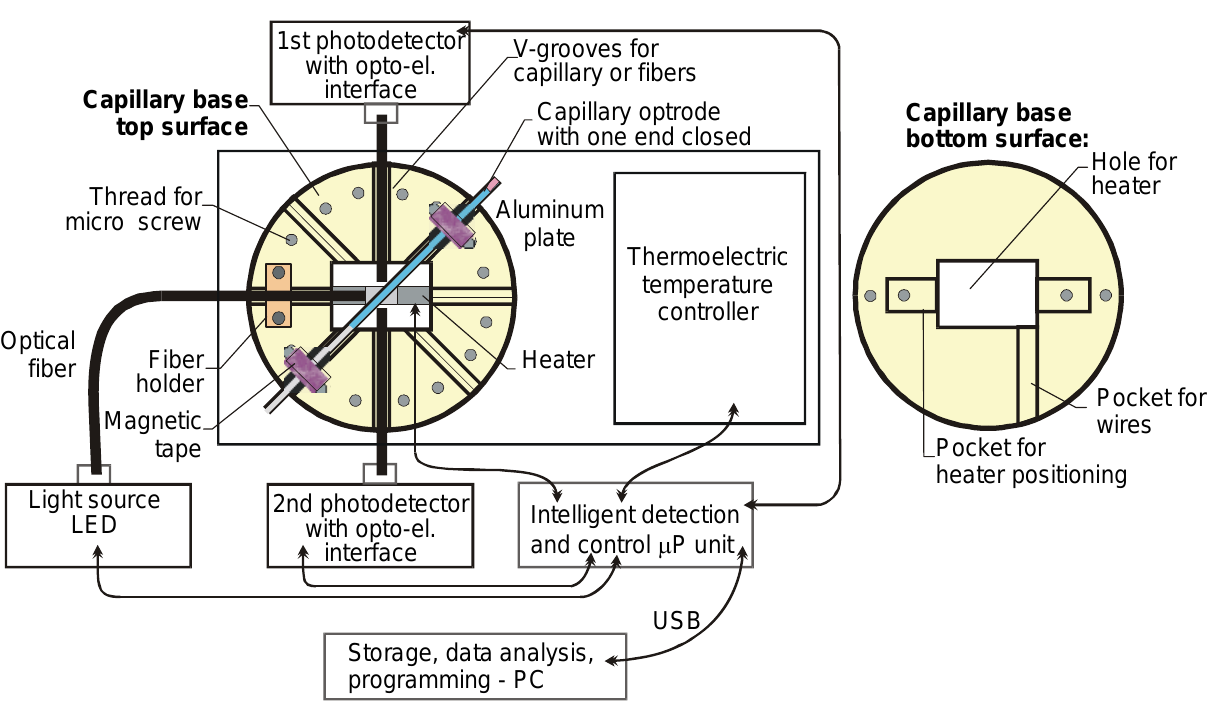
Figure 15. Microfluidic head with a replaceable capillary